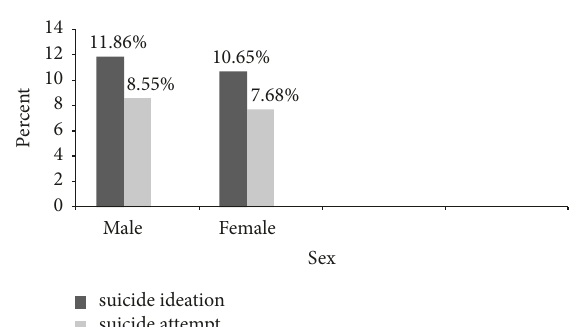
Figure 1: Lifetime suicide ideation and suicide attempt by gender among adolescent high school students in Dangila Town, Northwest Ethiopia, 2015.